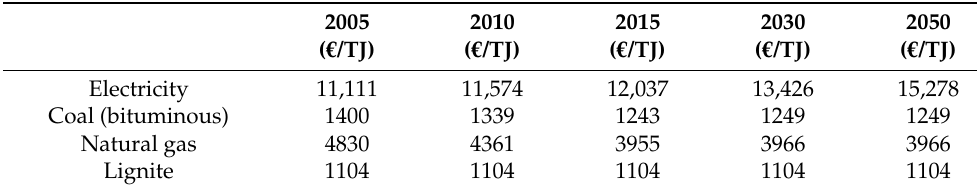
Table 5. Assumption of